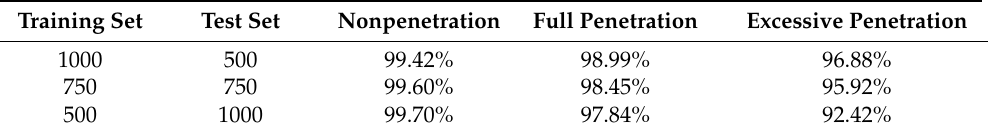
Figure 12. Recognition results of the penetration state by using another training method of recog- nition model.